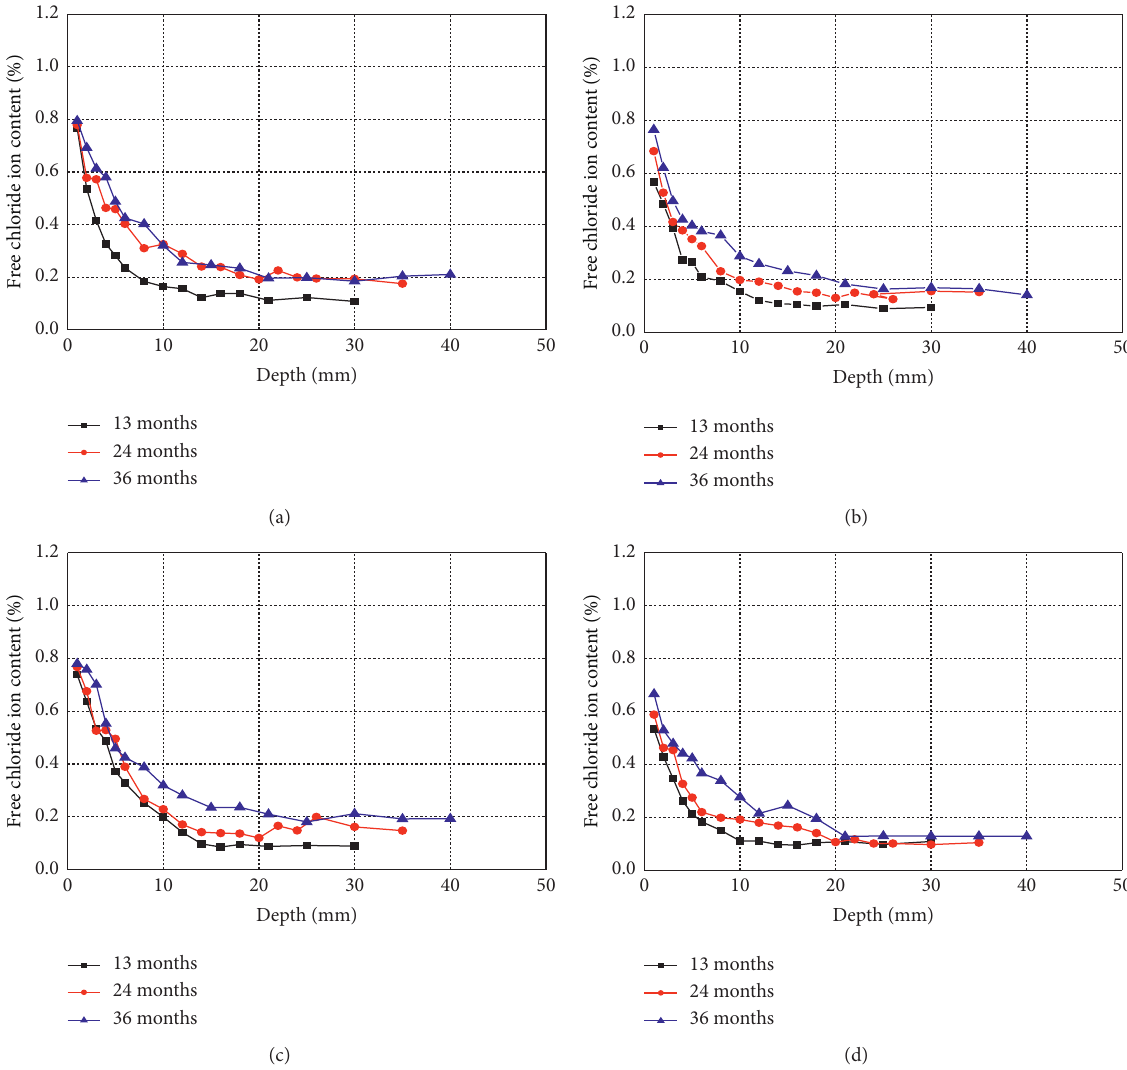
Figure 8: Chloride ion profile of concrete mixed with GGBS. (a) GGBS � 15%. (b) GGBS � 30%. (c) GGBS � 50%. (d) GGBS � 65%.